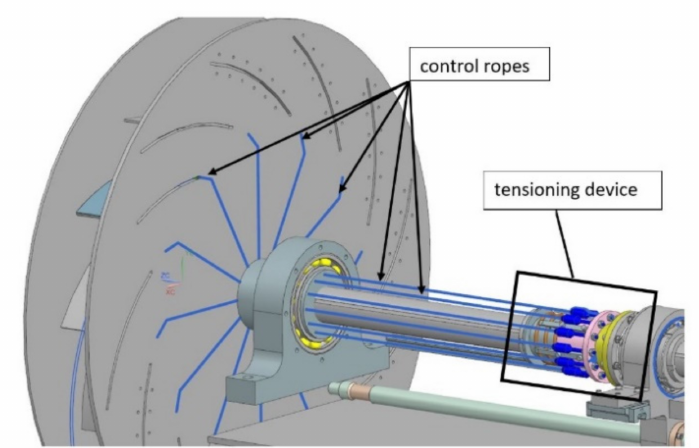
Figure 8. General view of the rope blade control system.